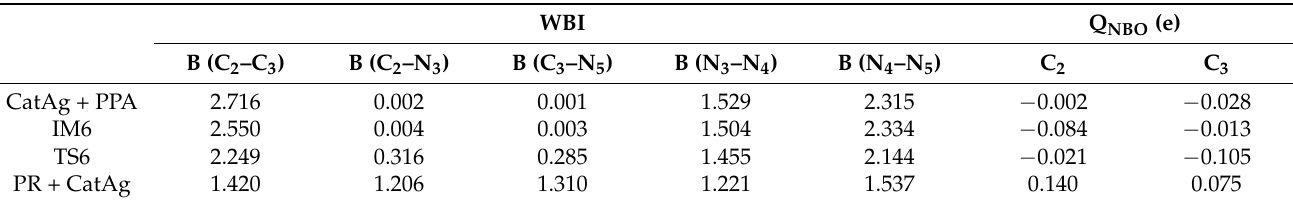
Table 5. WBI and Q NBO values for cycloaddition reaction. WBI Q NBO (e)